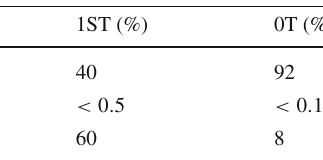
Fig. 7 Invariant mass distribution for the background plus an injected 2 TeV Z (cid:2) signal in the six event classes, before and after GenT tagging Table 2 Background composition for m JJ ∈ [ 1 . 7 , 2 . 3 ] TeV, for the six event